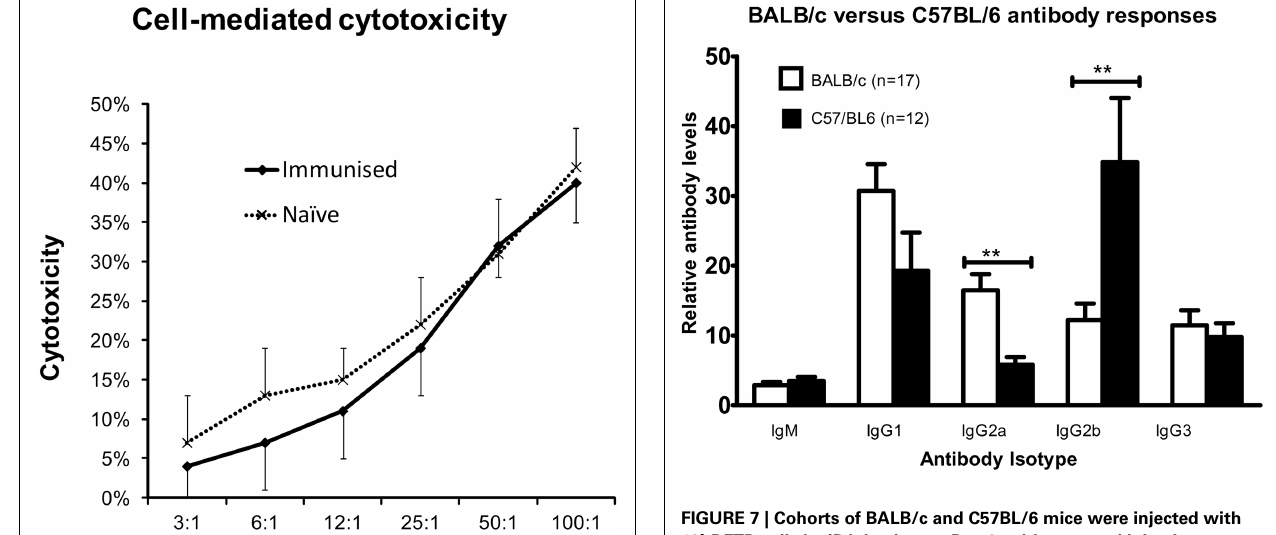
FIGURE 7 | Cohorts of BALB/c and C57BL/6 mice were injected with 10 6 DFTD cells by IP injection on Day 0, with a second injection between day 14 and 16; serum was collected 7–8days later .While anti-DFTD antibody expression varied between individuals there was a consistent trend that BALB/c mice were skewed toward higher levels of IgG2a and lower levels of IgG2b compared to C57BL/6 mice (Data are expressed as mean ± SEM, probability calculated by unpaired Student’s t -test, ** P <